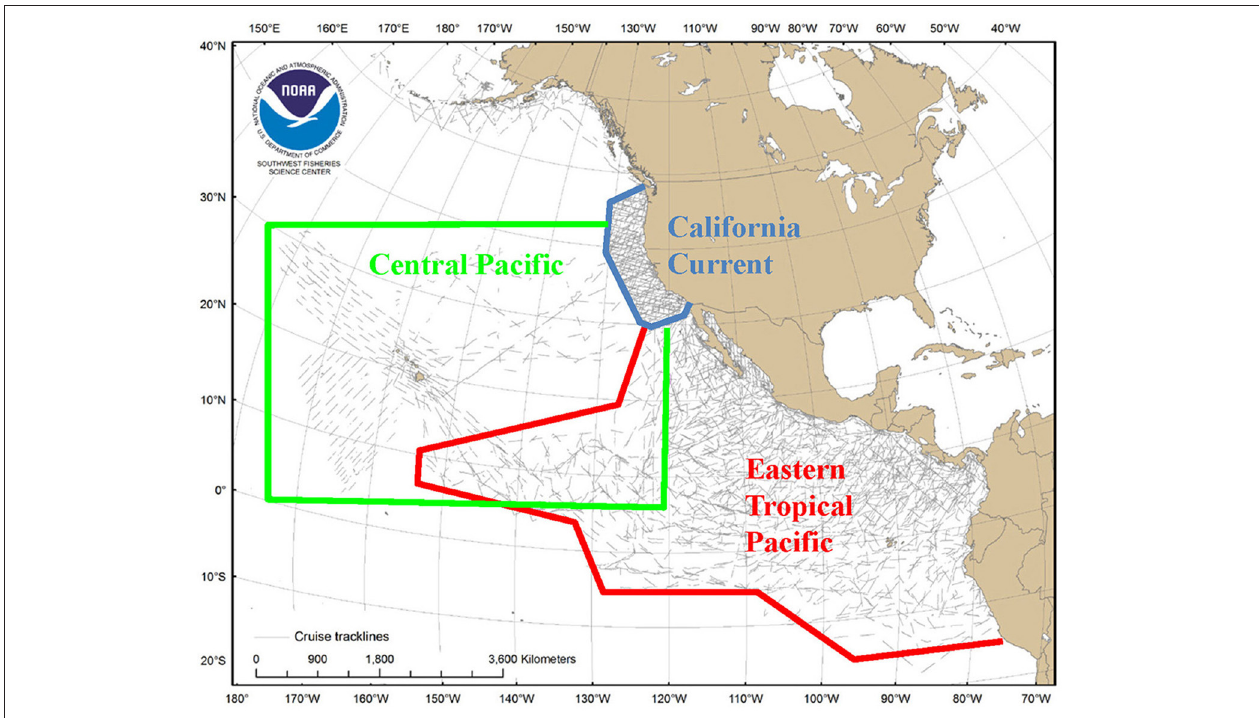
FIGURE A1 | (Case study 1) Transect coverage for surveys conducted by SWFSC between 1986 and 2006 in three broad study areas in the eastern North Pacific. Modified from Hamilton et al. (2009).